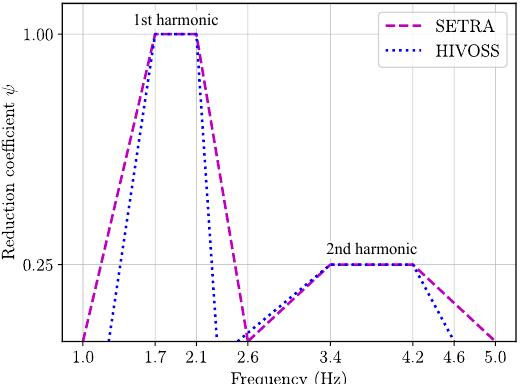
Figure 1. Reduction coefficient ψ for walking load models in the vertical